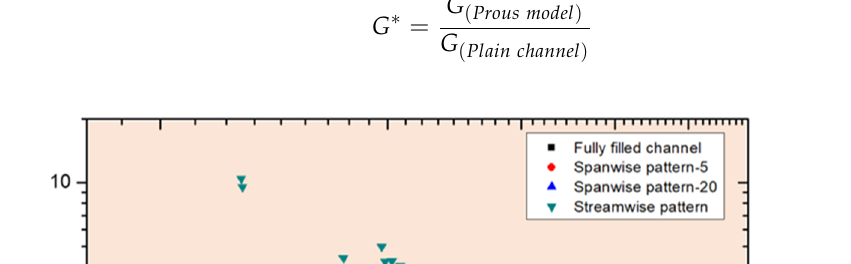
Figure 10. Comparison of ( a ) flow area’s goodness factor and ( b ) volume’s goodness factor of dif- ferent patterned models of porous media with the fully filled porous media channel and plain channel at G = 133 kg/m 2 s.